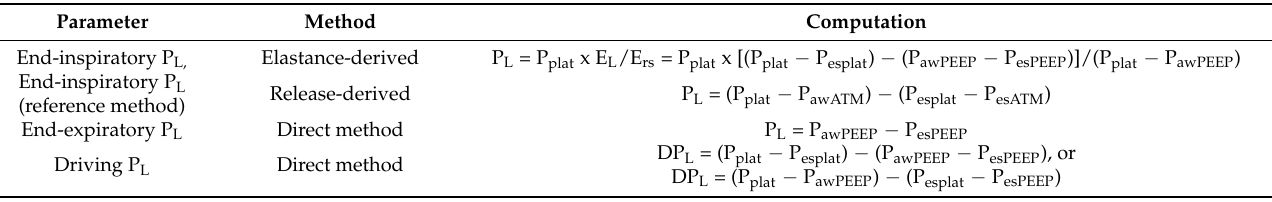
Table 1. Suggested methods to calculate inspiratory transpulmonary pressure, expiratory transpul- monary pressure, total transpulmonary pressure, and transpulmonary driving pressure. All pressures must be measured under static conditions after the airway occlusion maneuver. Adapted from Mieto et al. [9] and Grieco et al.